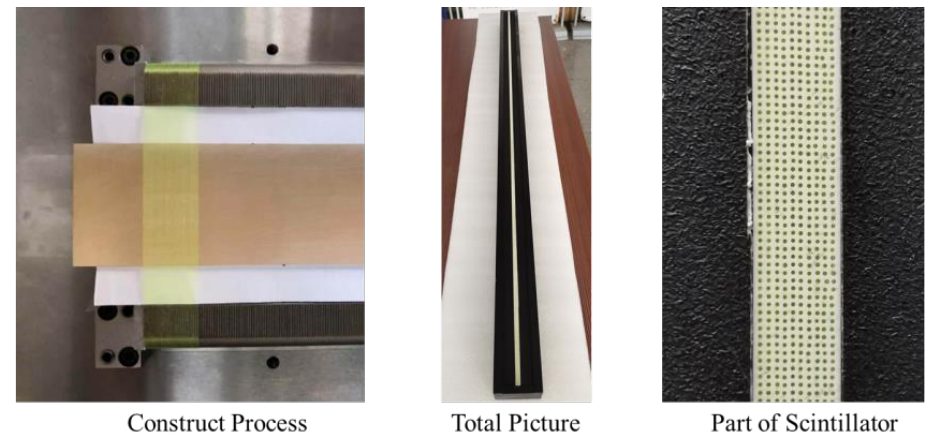
Figure 7. Pictures of the line array scintillator .